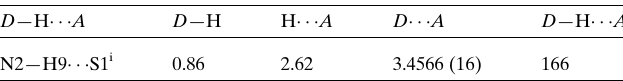
Table 1 Hydrogen-bond geometry (A˚ , (cid:2)